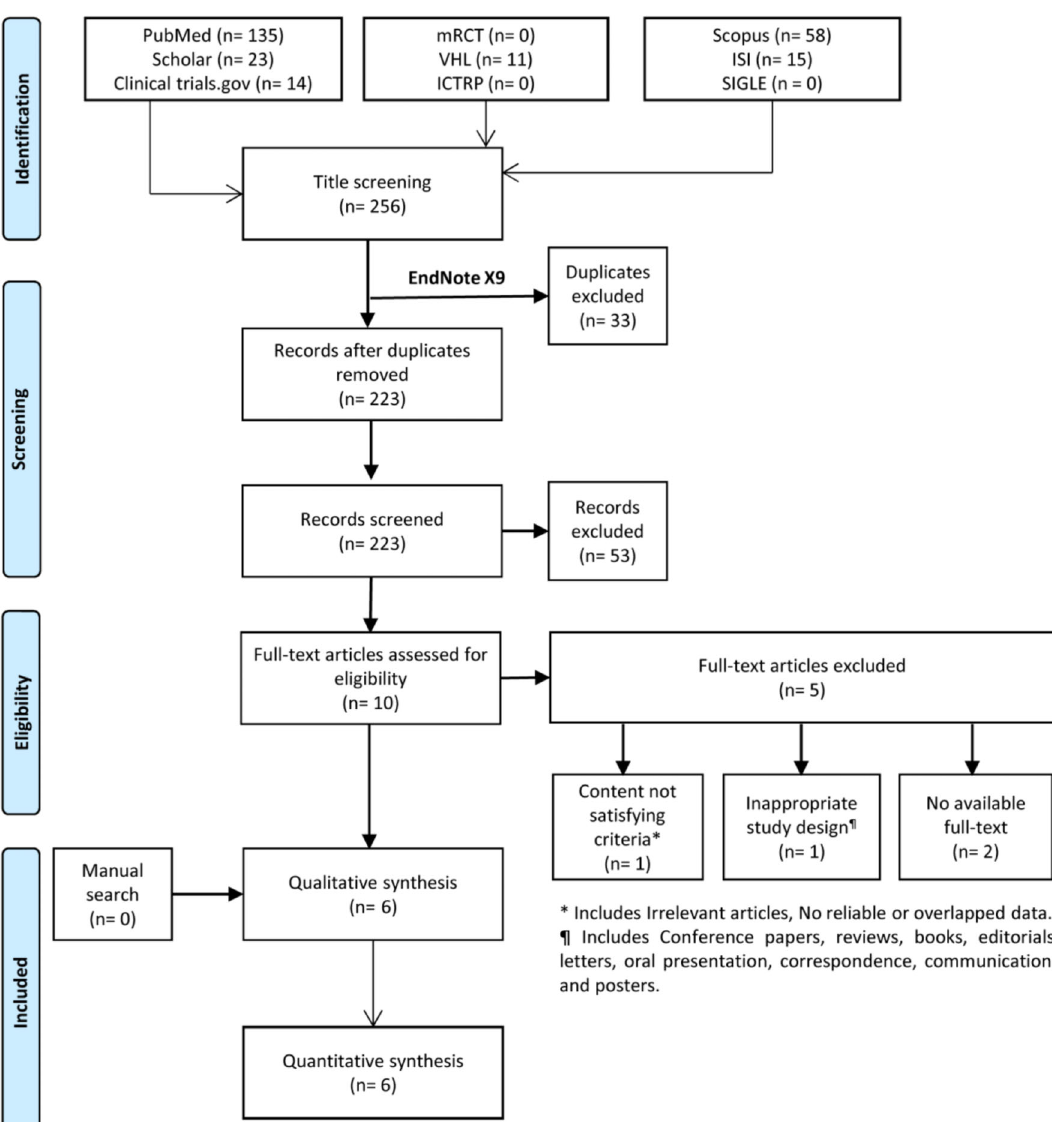
Figure 1 - PRISMA Flow diagram of the search and screening